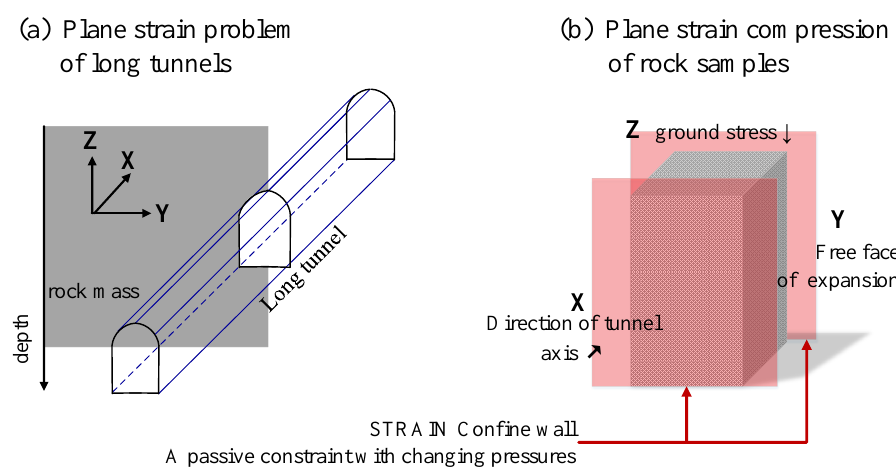
Figure 1. Plane strain problem of tunnels and PSC test of rock samples.